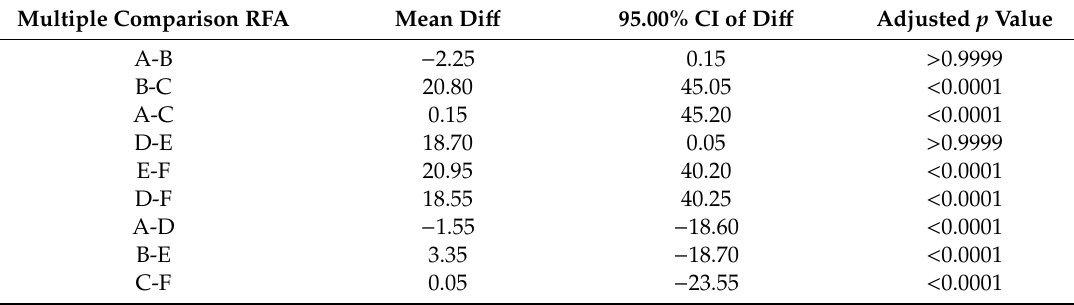
Table 6. RFA ANOVA Bonferroni post hoc groups comparison.